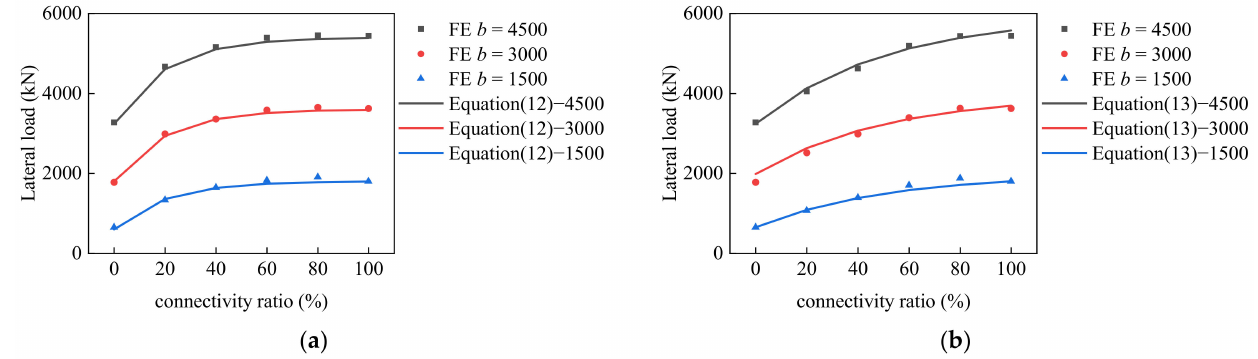
Figure 14. Comparison results of prediction equation and FE method for ( a ) S2 and ( b ) S2R